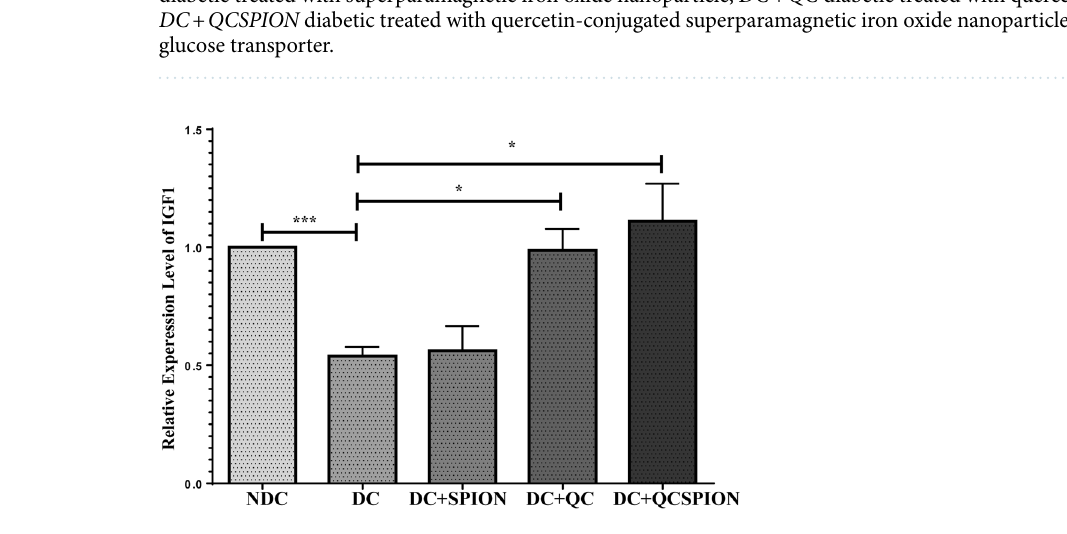
Figure 4. Effect of QC and QCSPIONs treatment on mRNA level of IGF-1 in the hippocampus of diabetic rats. Data are mean with SEM (n = 5 per group). *P < 0.05, ***P < 0.001 vs DC group (One-way ANOVA, Tukey’s multiple comparison tests). NDC non-diabetic control, DC diabetic control, DC + SPION diabetic treated with superparamagnetic iron oxide nanoparticle, DC + QC diabetic treated with quercetin, DC + QCSPION diabetic treated with quercetin-conjugated superparamagnetic iron oxide